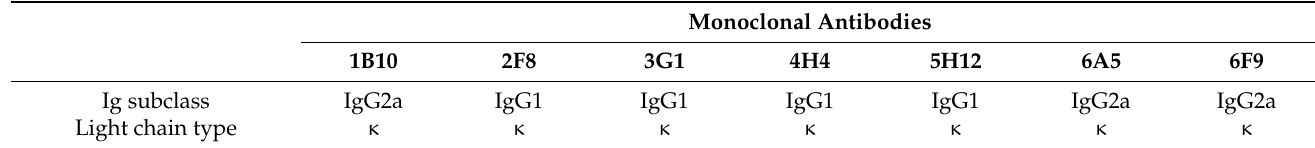
Table 2. Identification of subclasses of anti-p54 monoclonal antibodies.